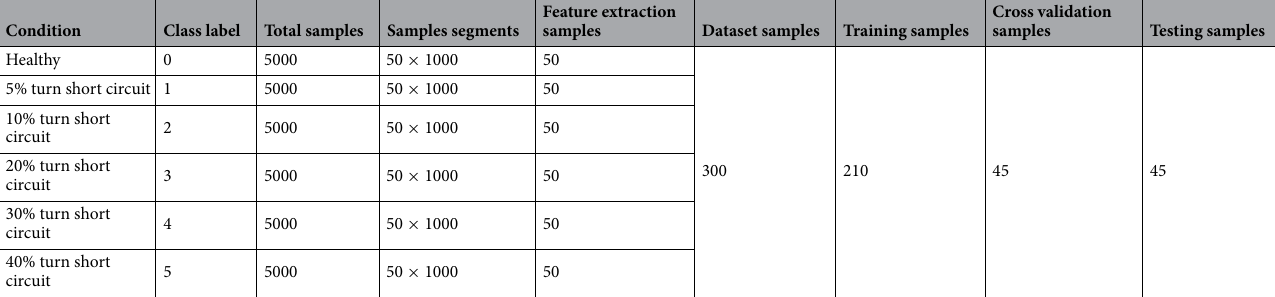
Table 3. Total dataset segment.